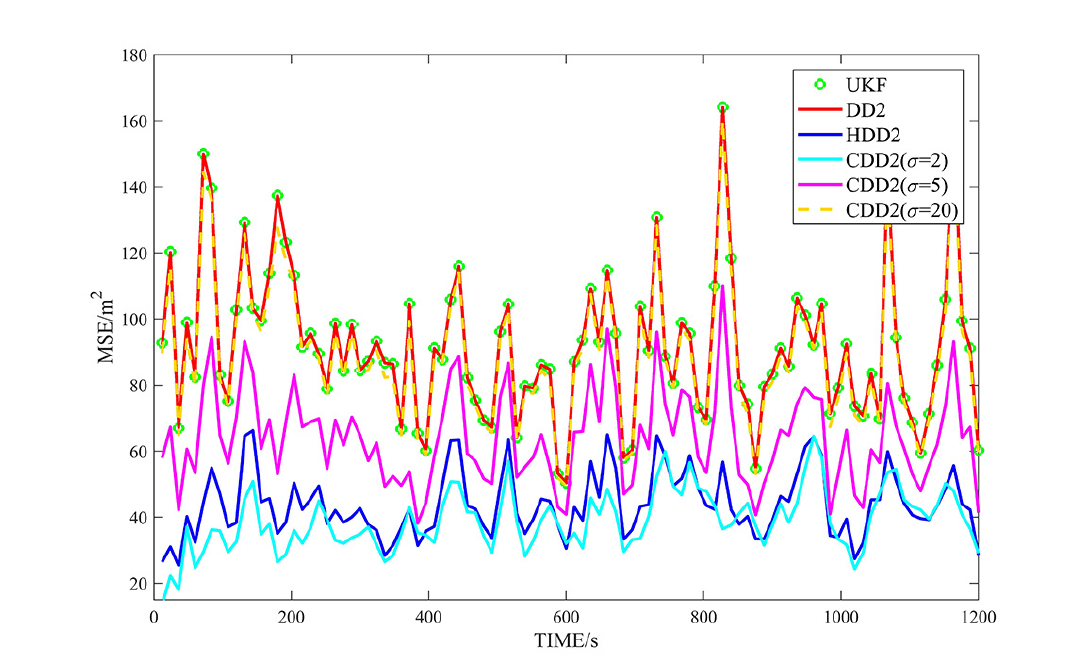
Figure 4. MSEs of ϕ with second-order approximate filters in non-Gaussian noises.